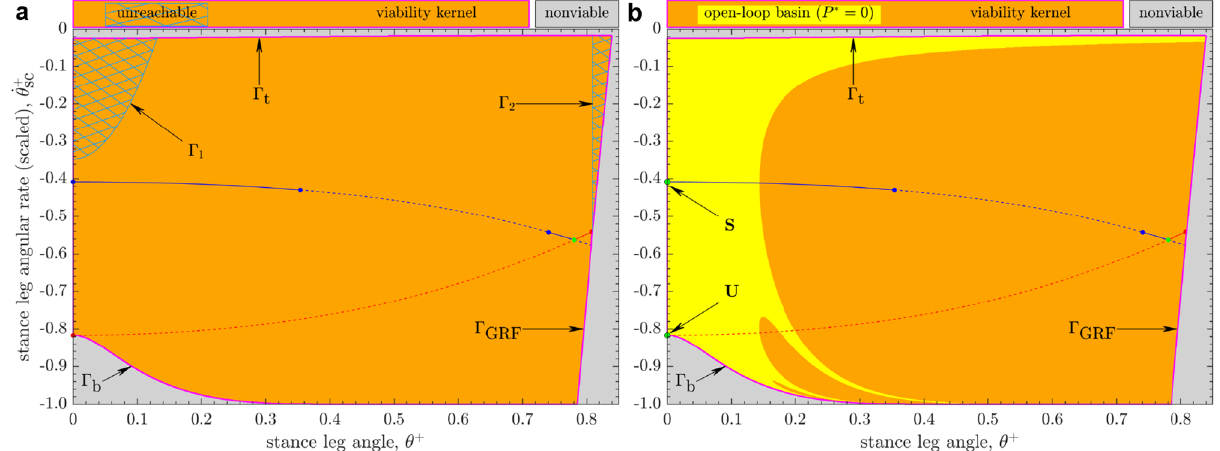
Figure 3. The ∞ -step viable region or the viability kernel V in the scaled state space (Fig. 2b) of the powered compass walker, numerically approximated via Algorithm 1 as the 18-step viable region V 18 after convergence on a grid. The set V , bounded by the curves { Ŵ b , Ŵ t , Ŵ GRF } , is a strict subset of the 1-step viable region V 1 (Fig. 2): indeed, states within V 1 (or “1-step” region 19 ) that are either below Ŵ b or above Ŵ t are nonviable . The boundary Ŵ GRF is common to both V and V 1 . The curves of long- and short-period gaits are from Fig. 2. ( a ) The two unreachable subsets ( hatched regions) of V , demarcated by the boundaries Ŵ 1 and Ŵ 2 , cannot be traversed by the walker. ( b ) The open‑loop basin of attraction with zero push-off ( P ∗ = 0 ) is a subset of V , within which trajectories approach the steady-state long-period gait S at { (θ ∗ , ˙ θ ∗ ) ; P ∗ } = { ( 0, 0 ) ; 0 } . The basin boundaries form the stable set 19,48 of the unstable short-period gait U (a saddle point) at { (θ ∗ , ˙ θ ∗ ) ; P ∗ } = { ( 0, 0 ) ; 0 } and also contain the boundaries Ŵ b \ � high := { (θ + , ˙ θ + ) ∈ Ŵ b | θ + (cid:31) 0.37402 } and Ŵ t of V that the walker’s push-off can be chosen to make it walk forever beginning in almost all states for which it can have a legitimate heel strike (Eq. 4).